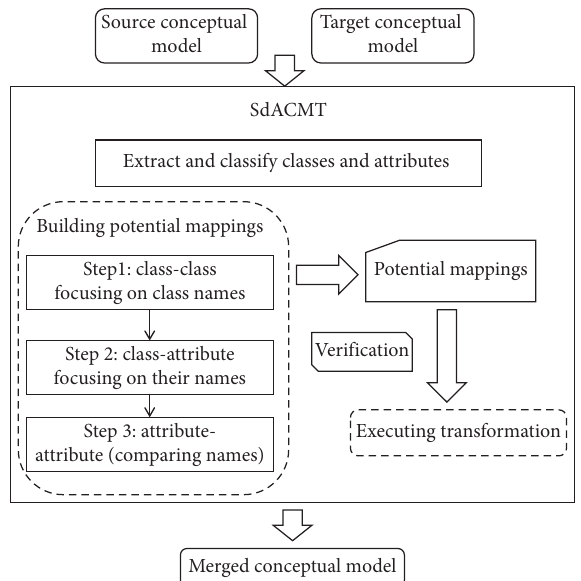
Figure 4: An overview of the matching